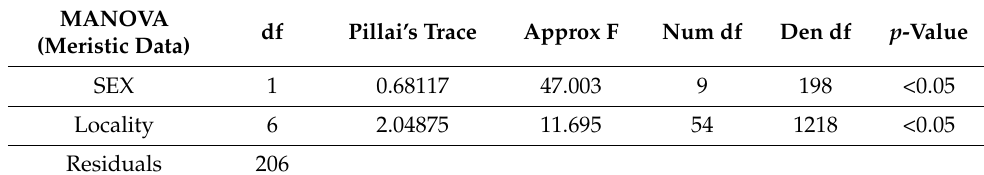
Table 3. ANOVA results. We reported the degrees of freedom (df), sum of squares (SS), mean squares (MS), F value and p -value.